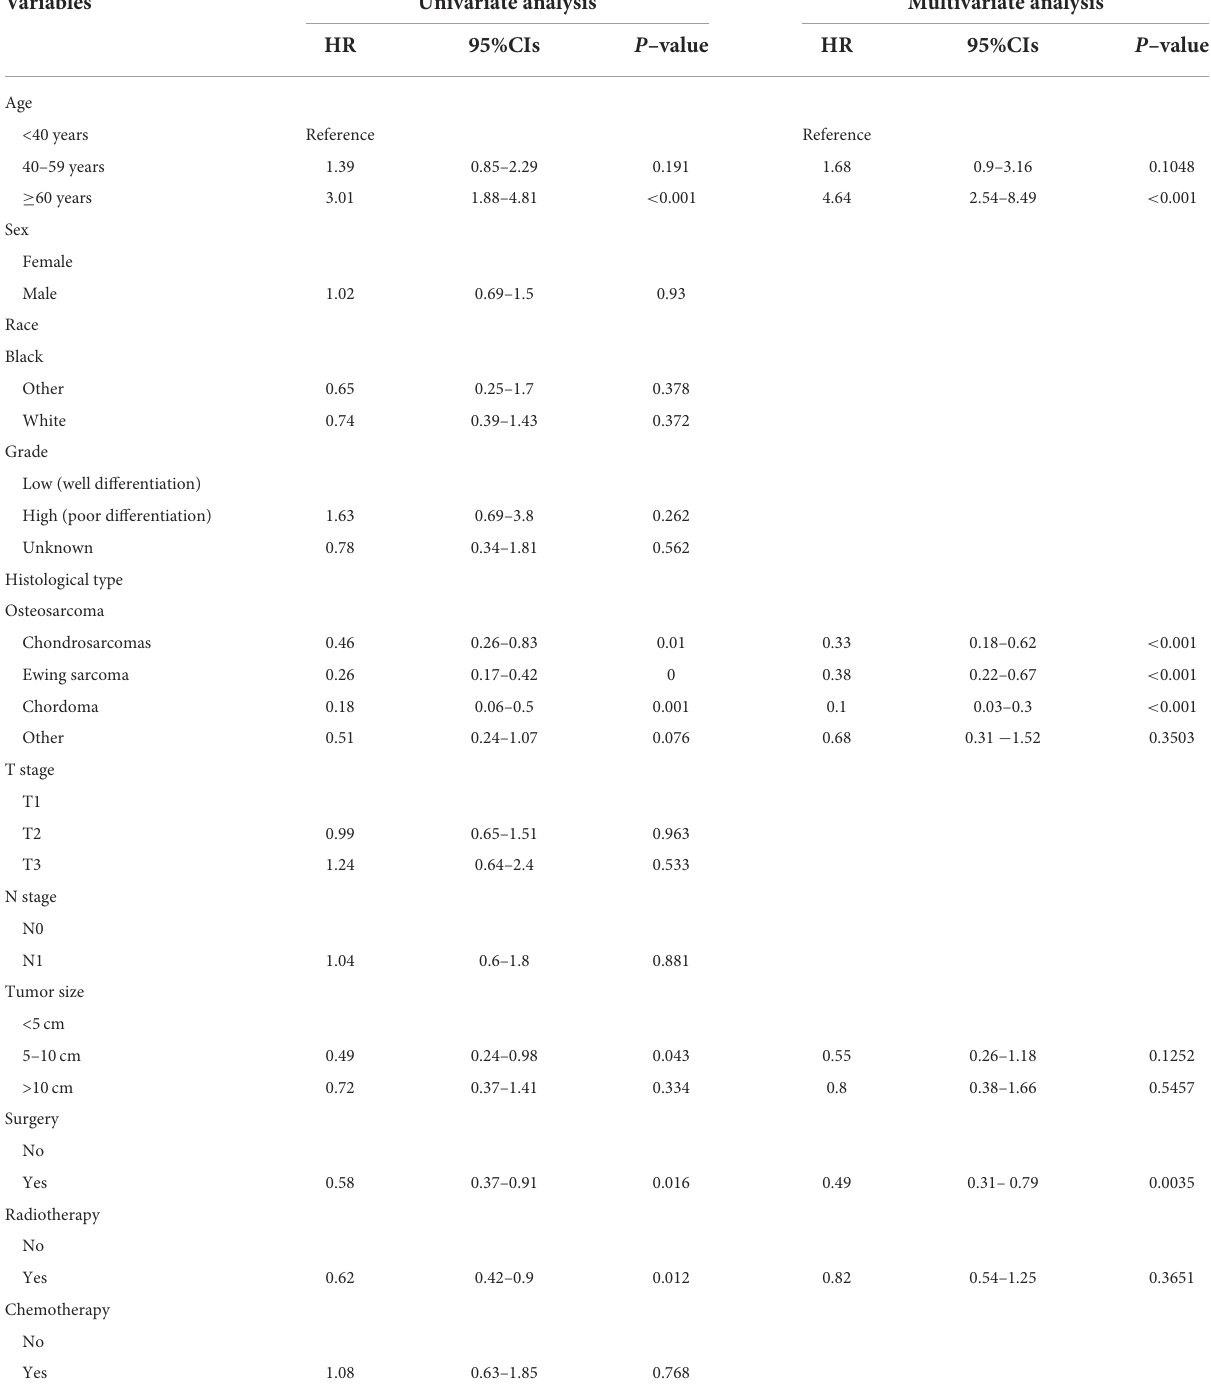
TABLE 4 Univariate and multivariate Cox regression analysis for identification independent prognostic factors in POSNs patients with DM. Variables Univariate analysis Multivariate analysis HR 95%CIs HR